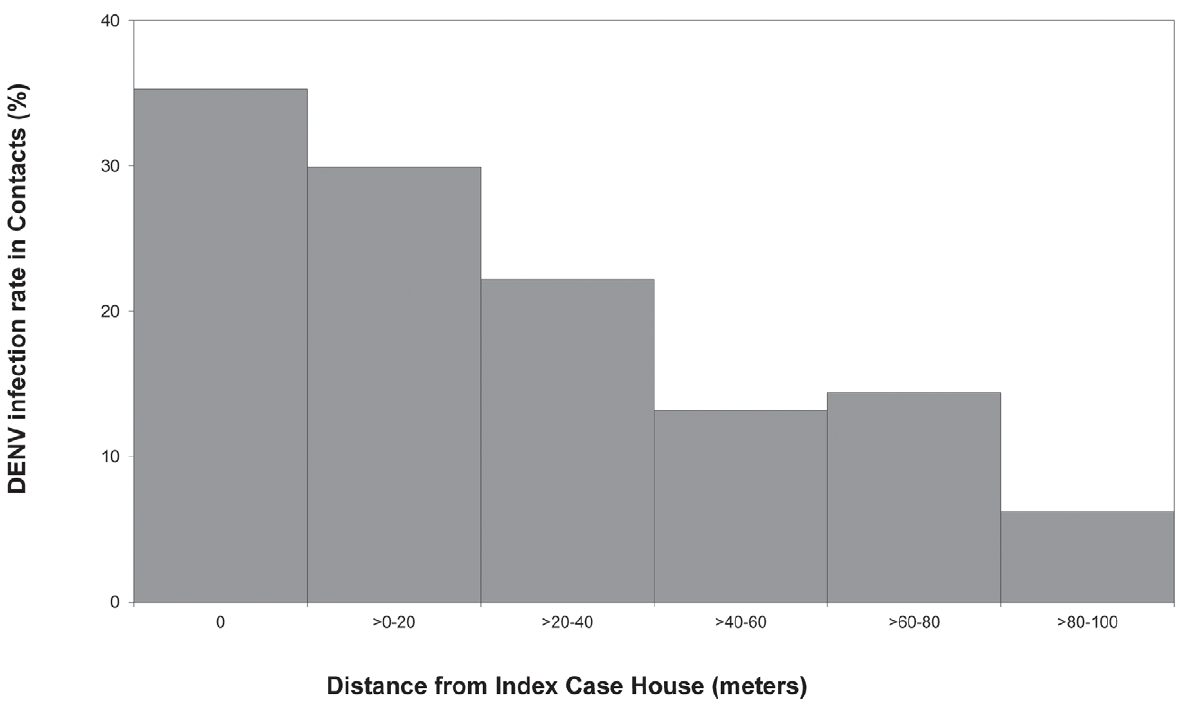
Figure 1. Focal aggregation of DENV-infected child contacts in positive clusters. Relationship between DENV infection rate and distance from index case house was significant (Chi square, p , 0.001). Distance from index case house 0 m: N=18/51; . 0–20 m: N=20/67; . 20–40 m: N=28/ 126; . 40–60 m: 23/174; . 60–80 m: 28/194; . 80–100 m: 12/193 (N=Infected Contacts/Enrolled Contacts).